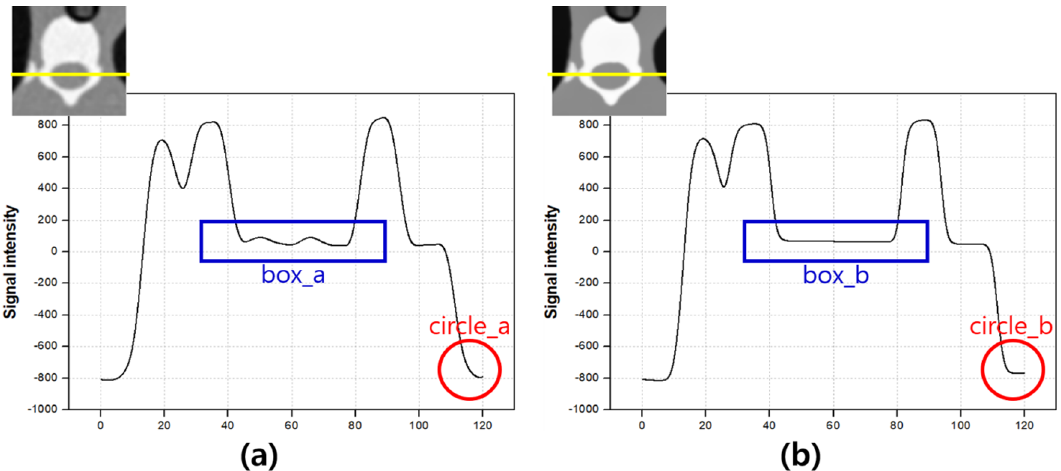
Figure 9. ( a , b ) are signal intensity profiles of the 5-year-old phantom images applied the Wiener filter and the FNLM denoising algorithm, respectively. The graphs represent the signal intensity of the yellow lines in the images. The boxes represent the denoising performance of the Wiener filter and the FNLM denoising algorithm. The circles represent the sharpness of the images.